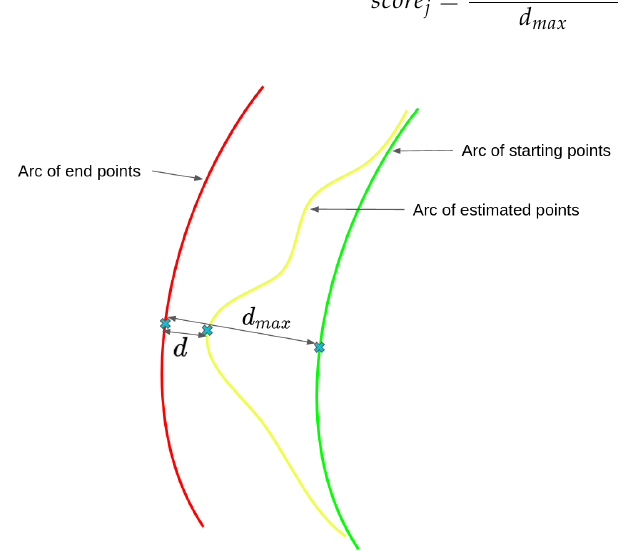
Figure 10. Description of the score calculation for one projected point, with the starting points (green), ending points (red), and estimated points (yellow) from the optical flow, as well as the distances used to compute the